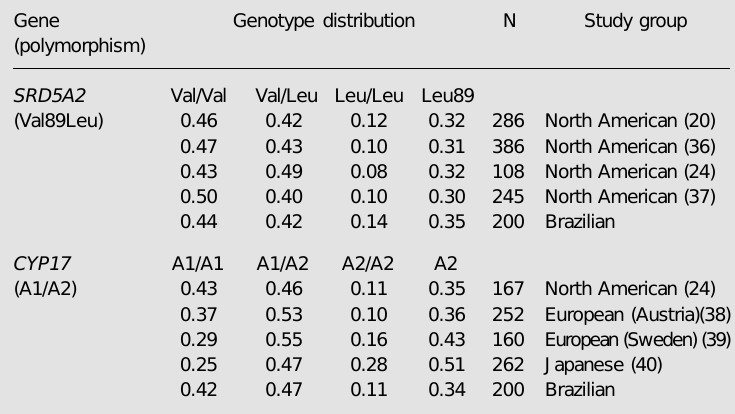
Table 5. Distribution of SRD5A2 and CYP17 genotypes in different populations.